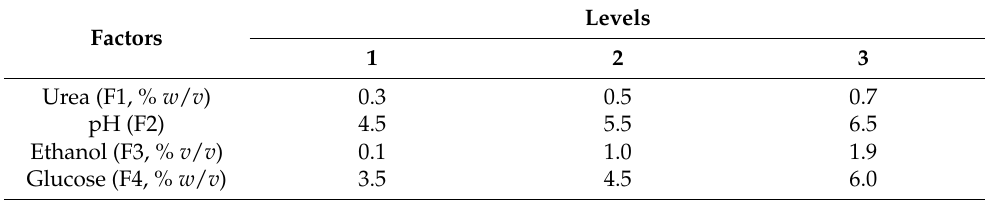
Table 1. Independent variable (factors) on medium composition based on GMW and their levels. Factors